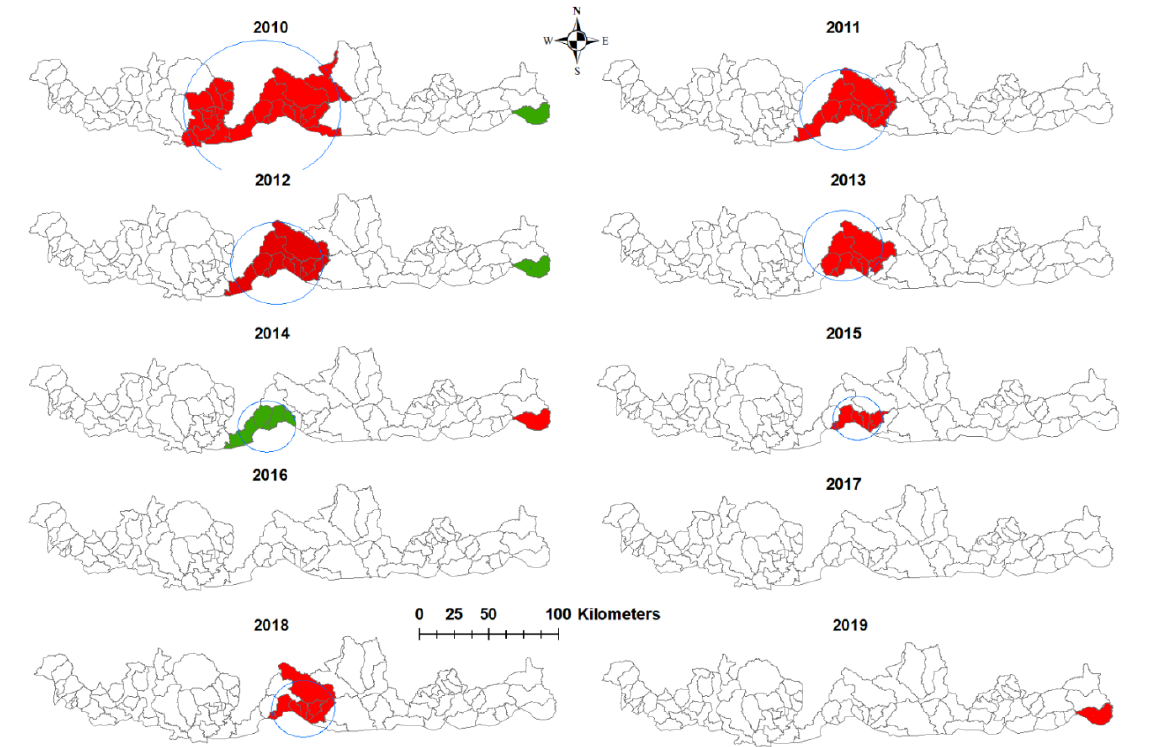
Figure 3. Spatial clusters of Plasmodium falciparum malaria in Bhutan by years, 2010–2019. (Red- most likely cluster; Green- secondary cluster).